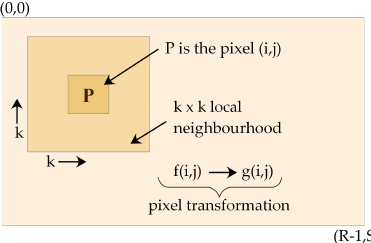
Figure 3. Pixelwise mask operation based on local